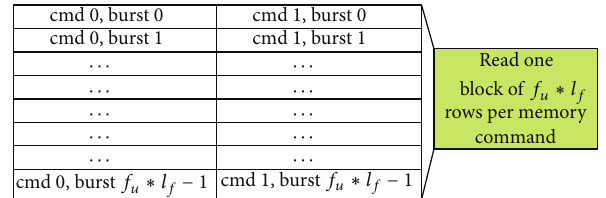
Figure 8: Illustration of memory access pattern for horizontal sums on Maxeler. Each burst spans 48 elements; every command generates access for an entire block of data. Inside each block, data needs to be reordered for the compute pattern.